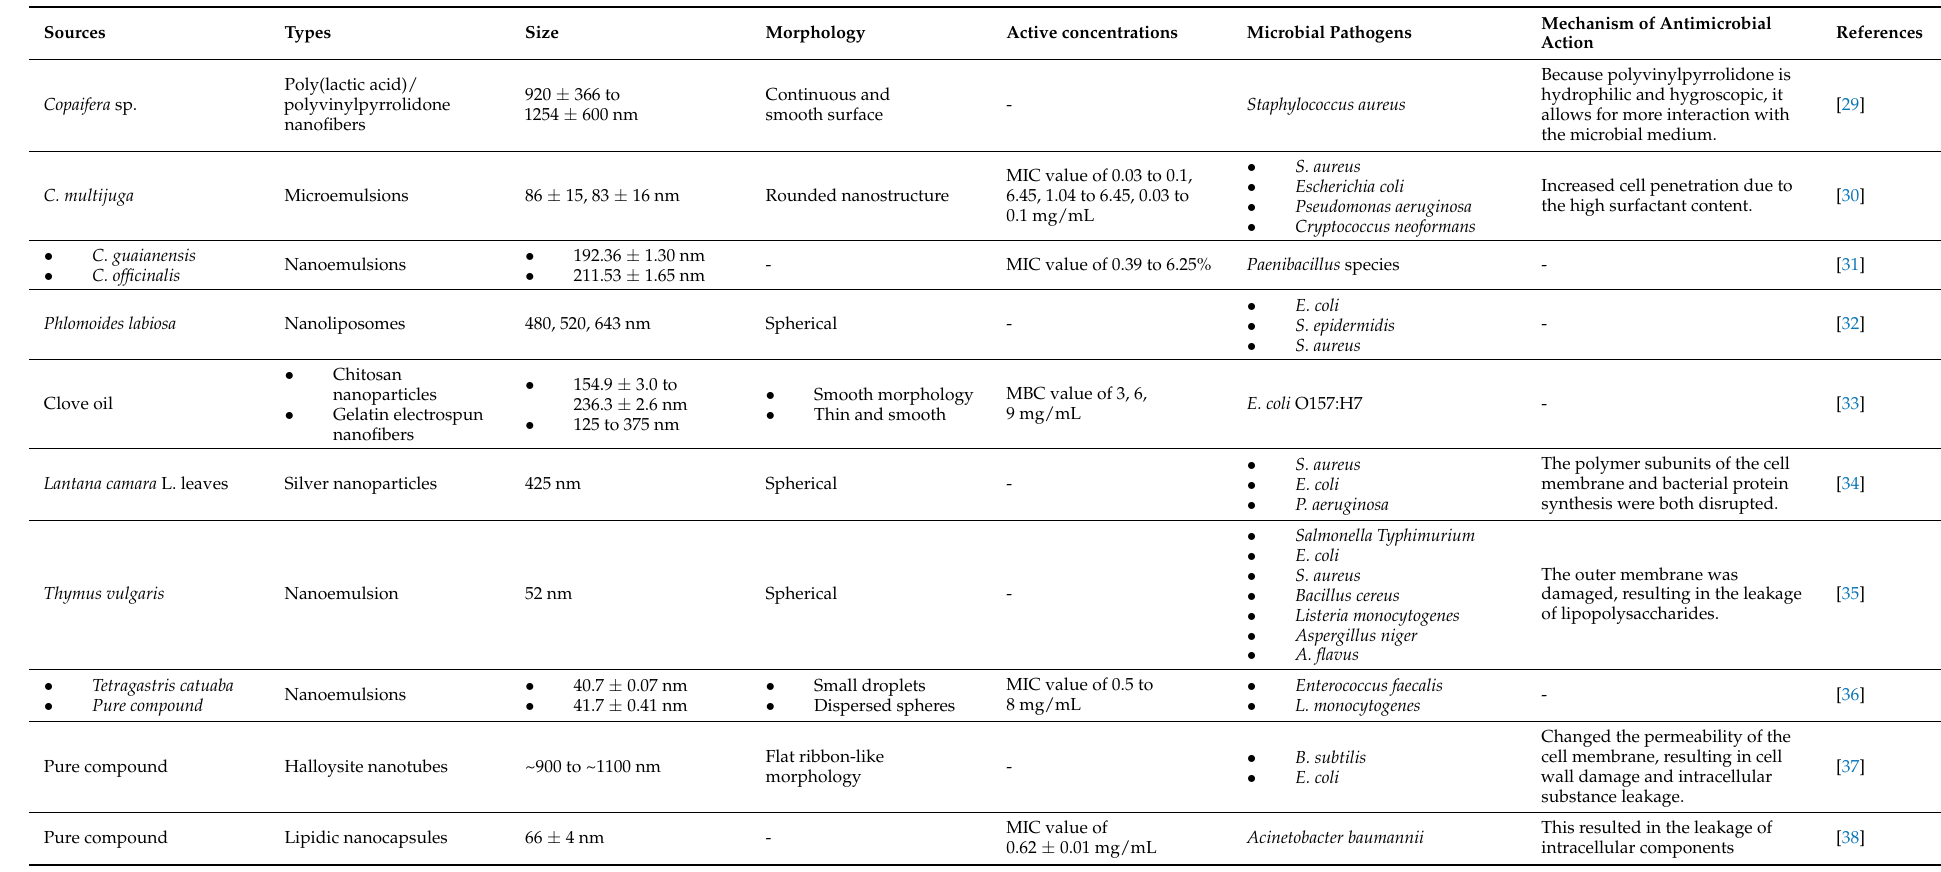
Table 1. Application of various plant materials containing β -caryophyllene in nanoformulation for the treatment of microbiological